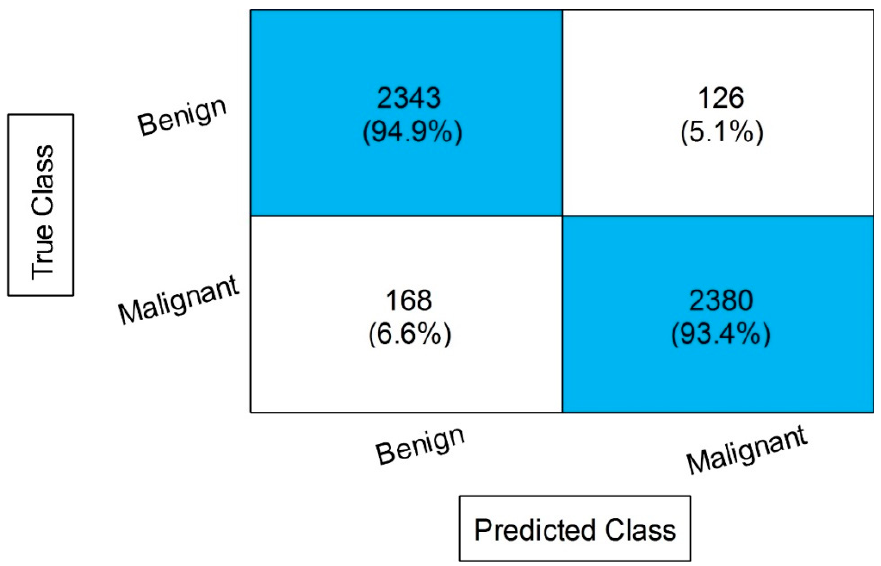
Figure 8. Confusion matrix of ESKNN after the proposed feature fusion.